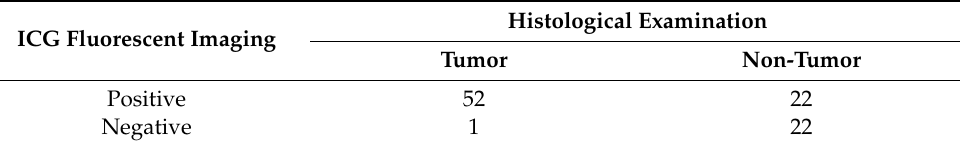
Table 1. Sensitivity and specificity of indocyanine green (ICG) fluorescent imaging test in the pulmonary metastases resections of hepatoblastoma.